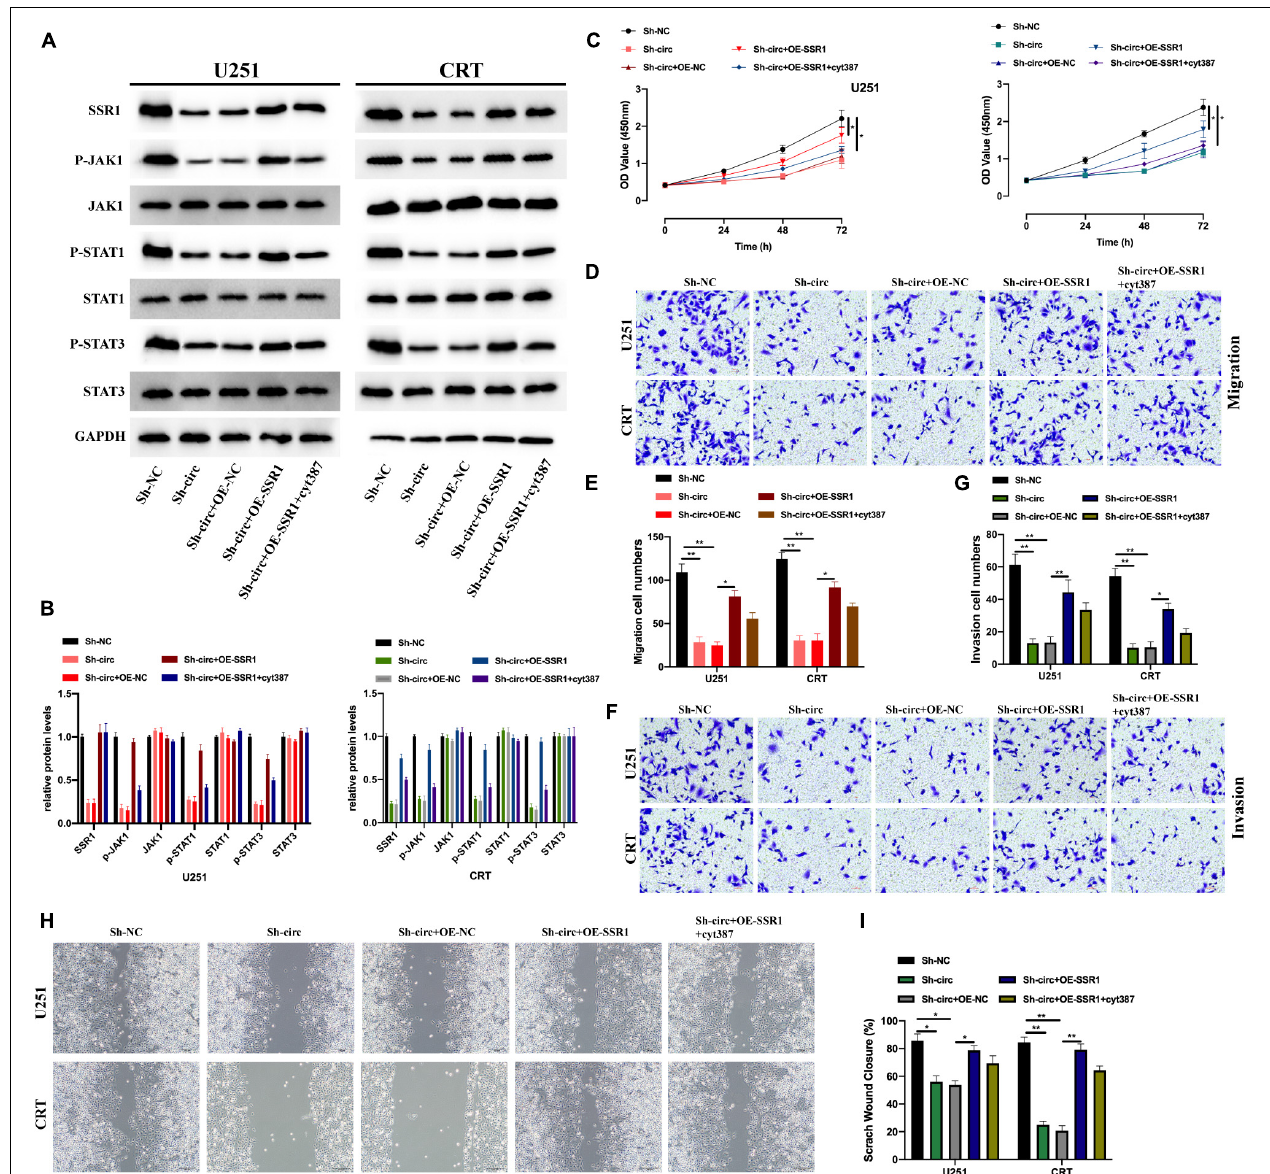
FIGURE 7 | CircTLK1 promotes gliomagenesis via the miR-452-5p/SSR1/JAK/STAT pathway. (A,B) The expressions of SSR1 and JAK/STAT pathway proteins in Sh-NC, Sh-circTLK1#1, Sh-circTLK1#1 + OE-NC, Sh-circTLK1#1 + OE-SSR1, and Sh-circTLK1#1 + OE-SSR1 + cyt387 transfected into U251 and CRT cells were detected using Western blot, and comparative statistics were analyzed. (C) CCK-8 was used to measure the proliferation levels. (D,E) Transwell migration assay was applied to measure migration abilities of treated U251 and CRT cells. (F,G) Transwell invasion assay was applied to assess cell invasion abilities of treated U251 and CRT cells, and comparative statistics are presented. (H,I) The migration level of transfected cells was detected using the scratch test, and results were analyzed as indicated. *p < 0.05 and **p <